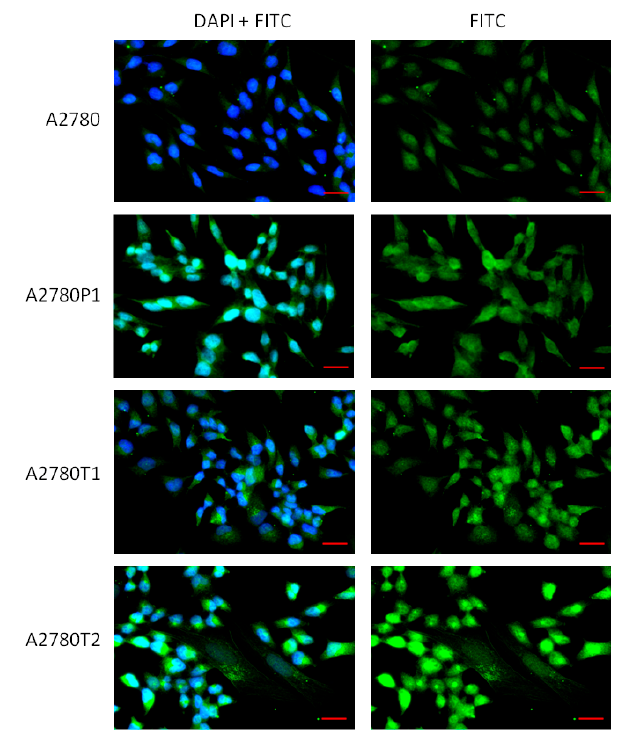
Figure 3. Immunofluorescence visualization of MGP protein expression in the A2780, A2780PR1, A2780TR1, A2780TR2 cell lines. MGP was detected using the anti-MGP antibody and MFP488-conjugated secondary antibody (green). To visualize the cell nuclei, the cells were mounted with a DAPI-containing mounting medium (blue). Scale bar = 20 μ m.